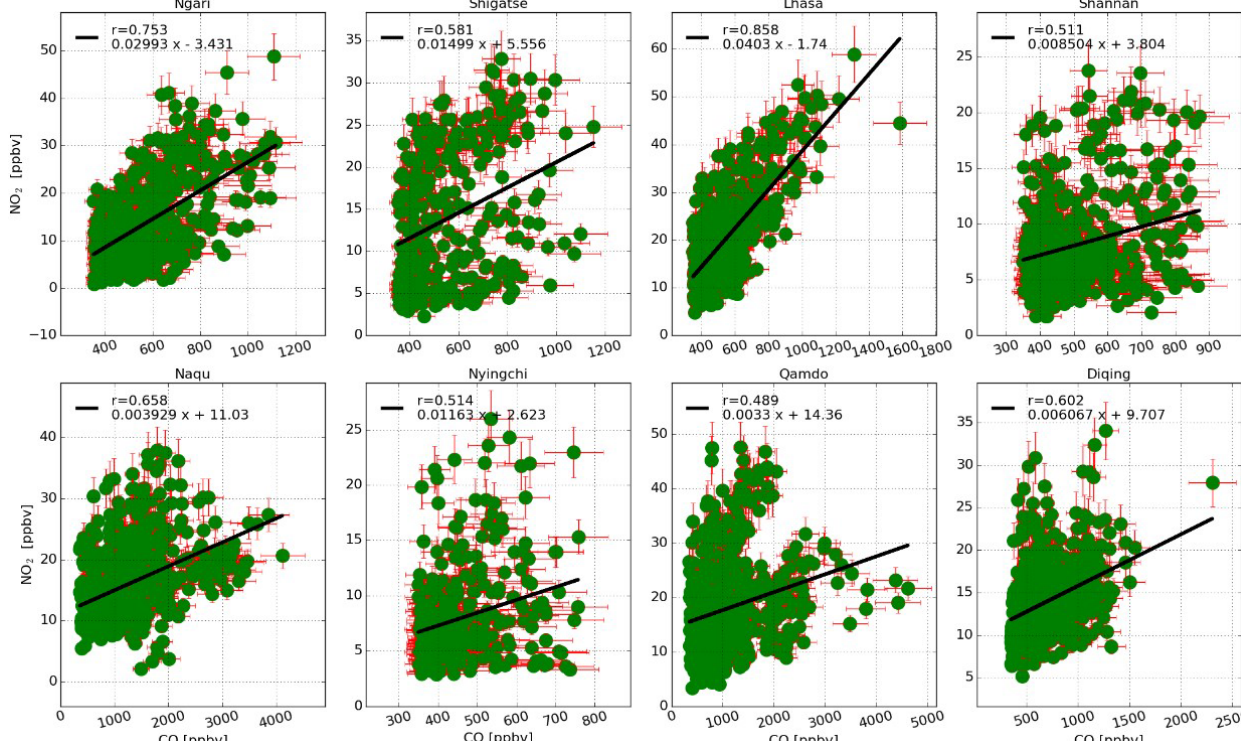
Figure 6. Correlation plots of surface CO vs. NO 2 VMR daily mean over the HTP. The black line is a linear least-squares fit of the respective data. The linear equation of the fit and the resulting correlation coefficient ( r ) are shown. Both CO and NO 2 time series are provided by the CNEMC network. Vertical error bar is 1 σ standard variation within that day.